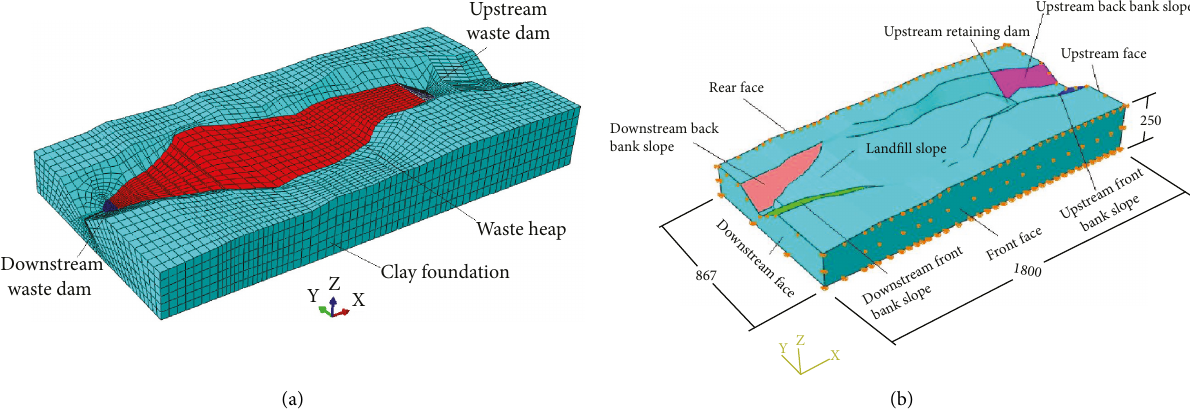
Figure 6: Three-dimension mesh model (a) and three-dimension model size and boundary conditions of the landfill (b). (a) Mesh of the landfill model. (b) Model size and boundary conditions